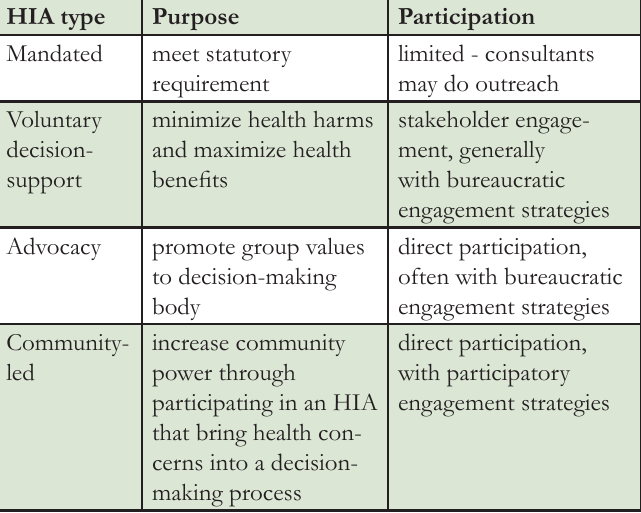
Table 2: HIA typology and typical participation